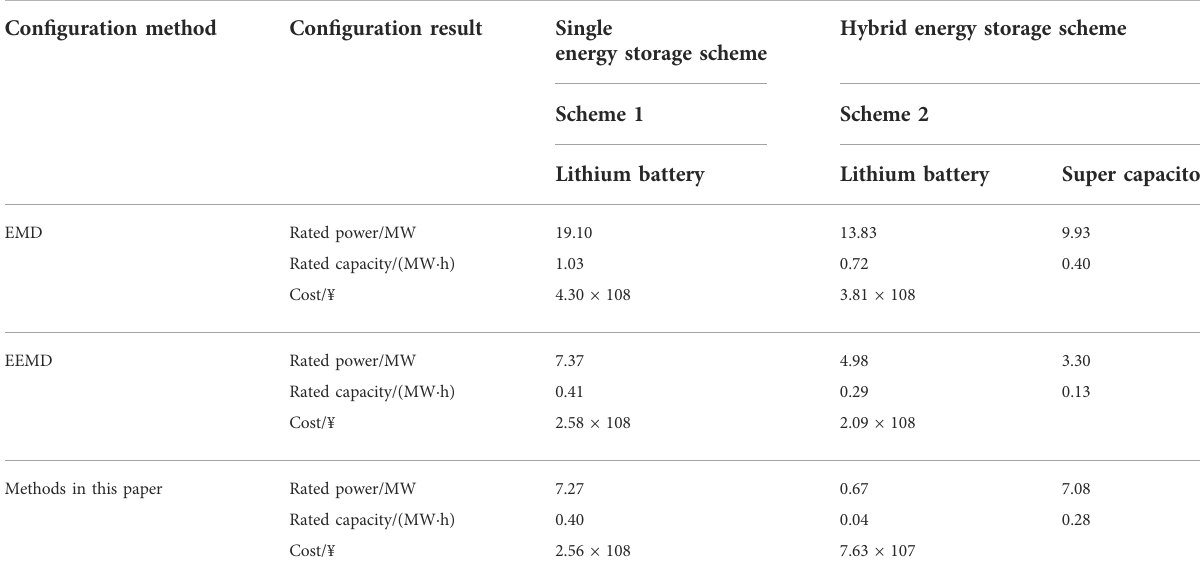
TABLE 1 Capacity con fi guration results of